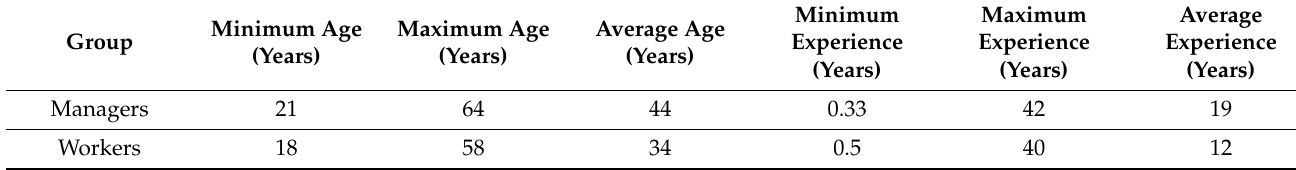
Table 3. The demographics of survey respondents.